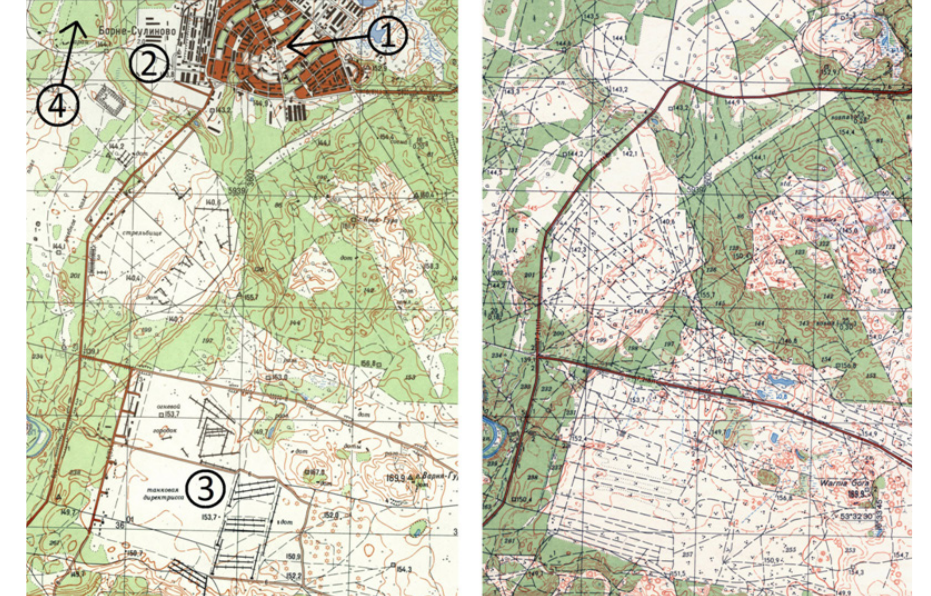
Fig. 9. The garrison of Borne Sulinowo with a training ground on the maps 1:25,000: on the left – the Soviet map, 1979, on the right – the Polish map,